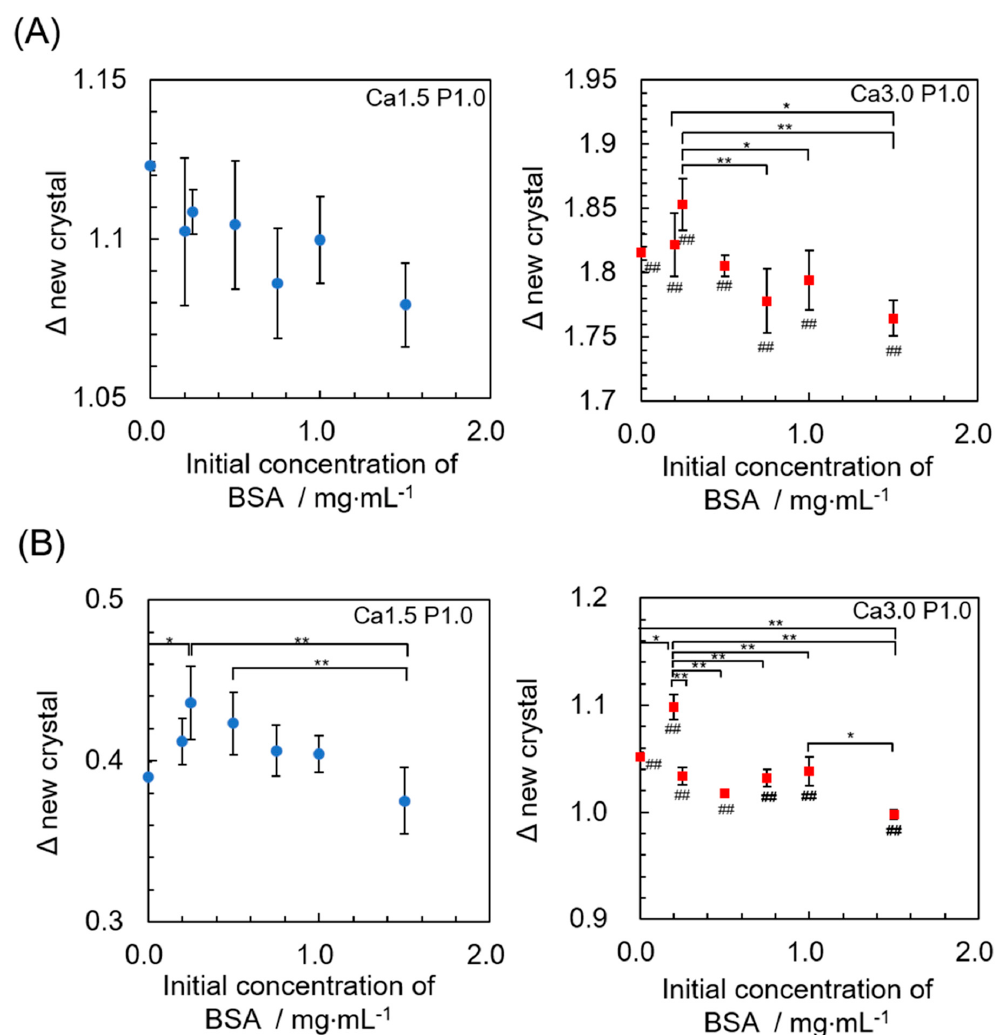
Figure 8. Change in the mass ratio of newly-formed calcium phosphate assuming that the OCP composition is the same as the original OCP determined from the decrease in the Ca 2 + ( A ) and Pi ion ( B ) concentration after incubation in the Ca3.0P1.0 or Ca1.5P1.0 solution containing BSA. Mean values were obtained from three independent experiments (n = 3). * p < 0.05, ** p < 0.01 significant di ff erence among the BSA concentrations in each supersaturated solution. ## p < 0.01 significant di ff erence between Ca1.5P1.0 and Ca3.0 P1.0 solution at each BSA